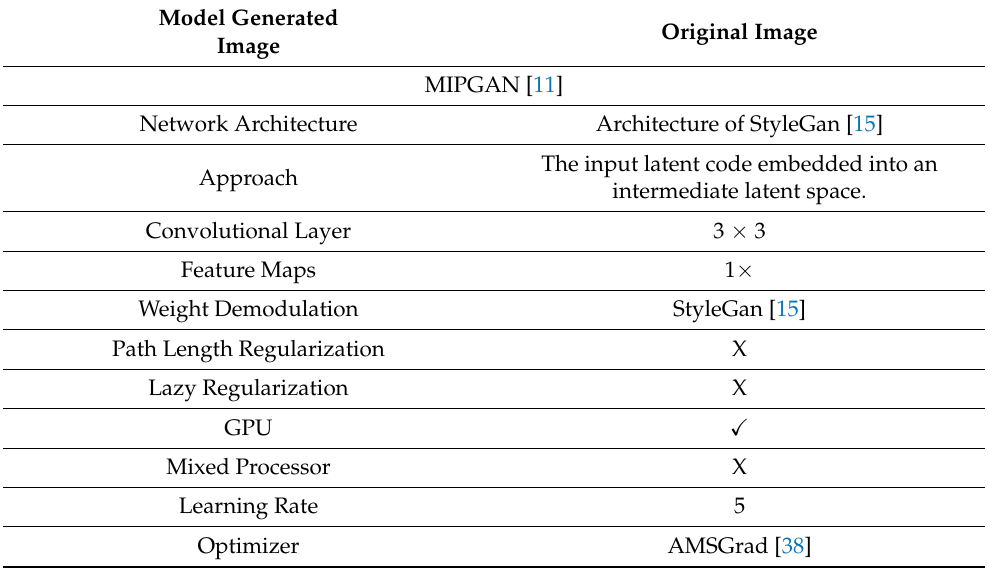
Table 5. Comparison of the proposed model with MIPGAN